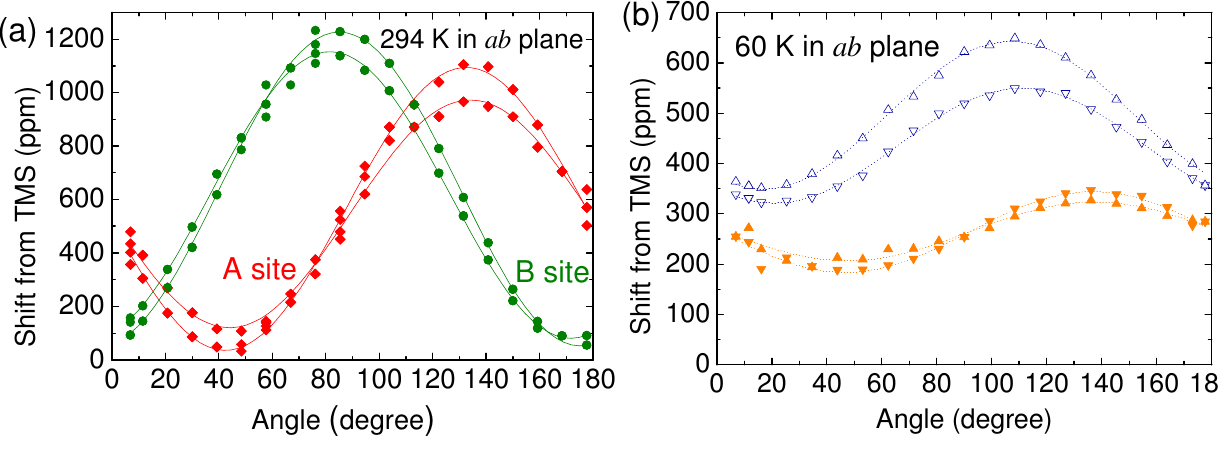
Figure 8. ( a ) Angular dependence of NMR shift at A and B local molecular sites at 294 K in ab plane rotation in α ' -(BEDT-TTF) and B local spin-poor molecular sites at 60 K in ab plane rotation in α ' -(BEDT-TTF) At 60 K, The principal axes of NMR shift are intensively different from that at 294 K for large disproportionation of spin susceptibility